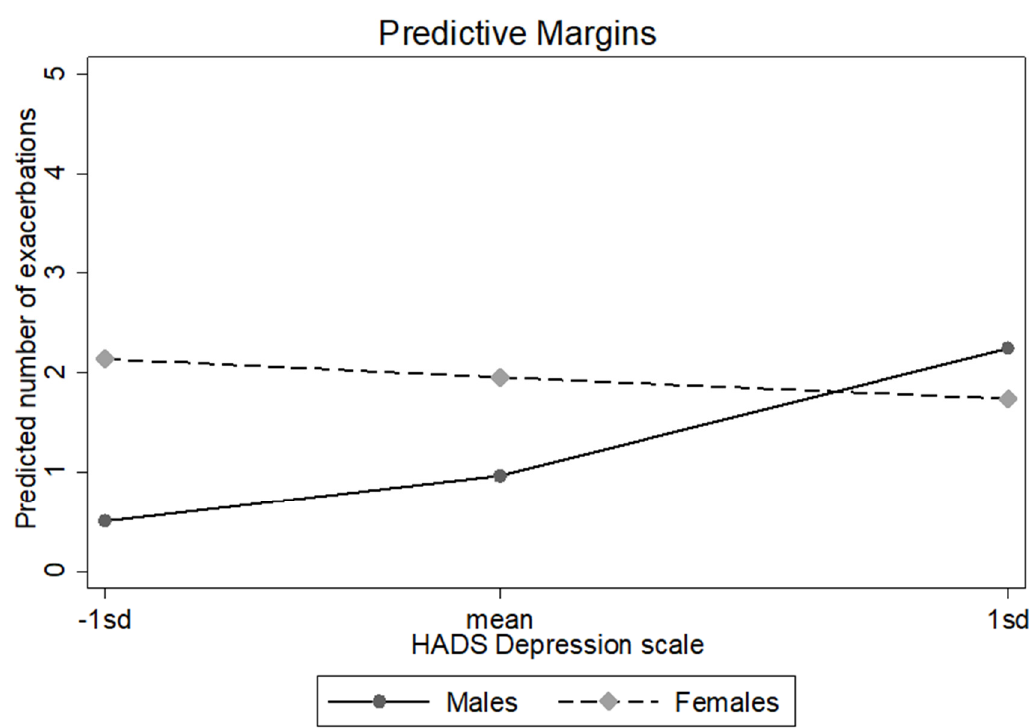
Figure 1. Effect of gender on exacerbations moderated by depression levels. Female patients experienced asthma exacerba- tions more frequently compared to male patients at the low level of the depression subscale (HADS-D).